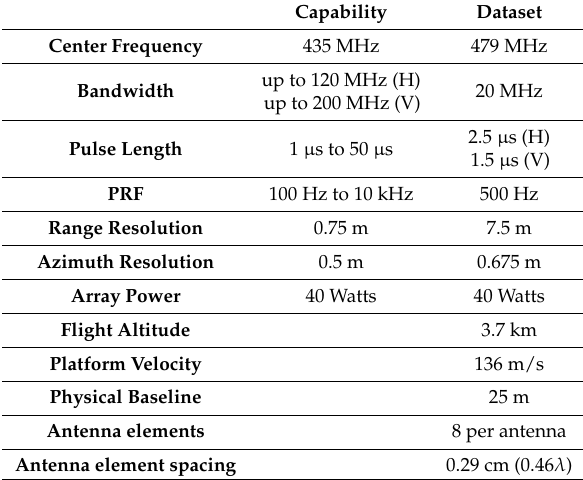
Figure 33. EcoSAR antenna mounted on a wing of the P3 airplane during the 2014 flight campaign ( left ) and illustration of antenna positions on each wing ( right ). Table 3. EcoSAR system parameters: Operational range (middle) and parameters of analyzed dataset